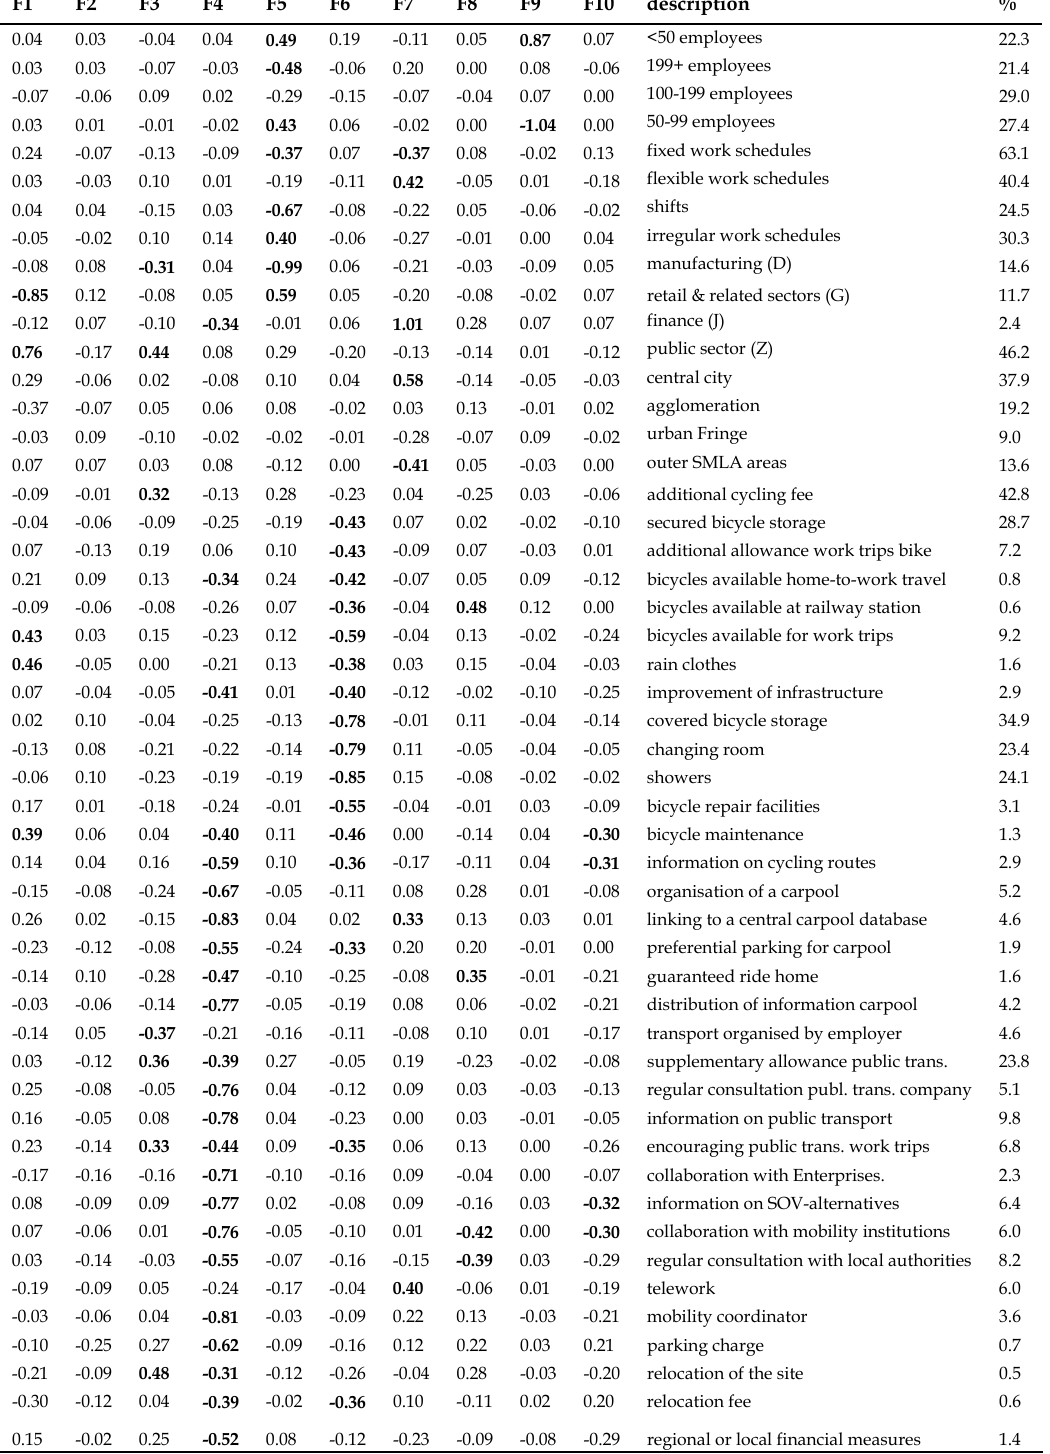
ANNEX 1: Table A: Factor loadings (Varimax rotated) of an EFA with 10 factors (values higher than 0.3 in bold; software: Mplus version 4.1; Muthén and Muthén,